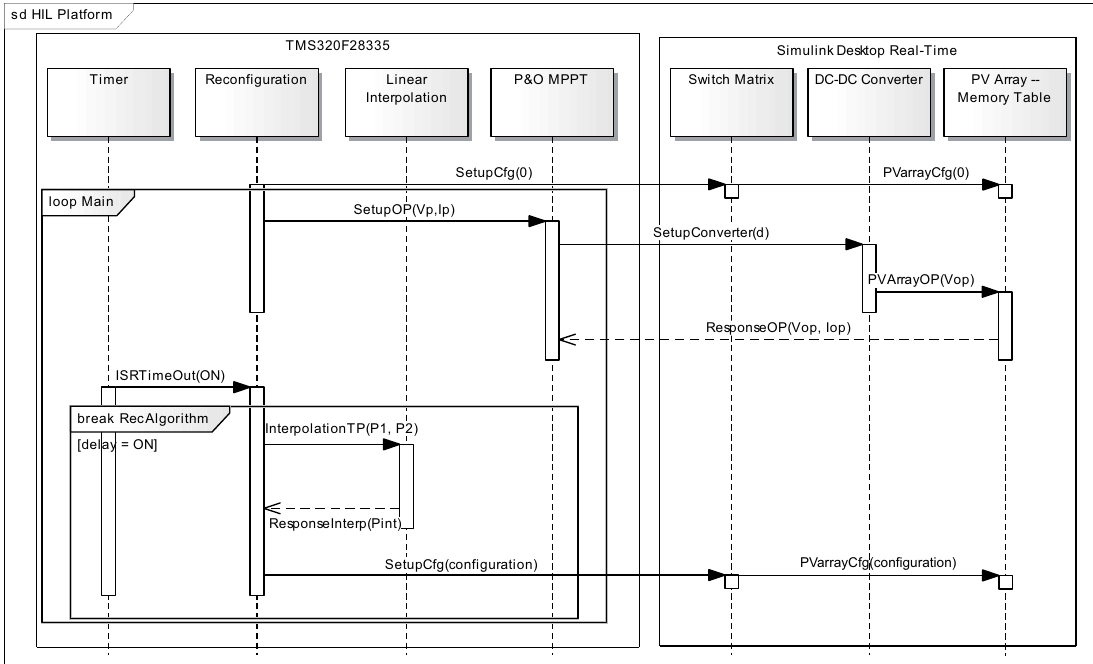
Figure 9. Sequence diagram of the simulation